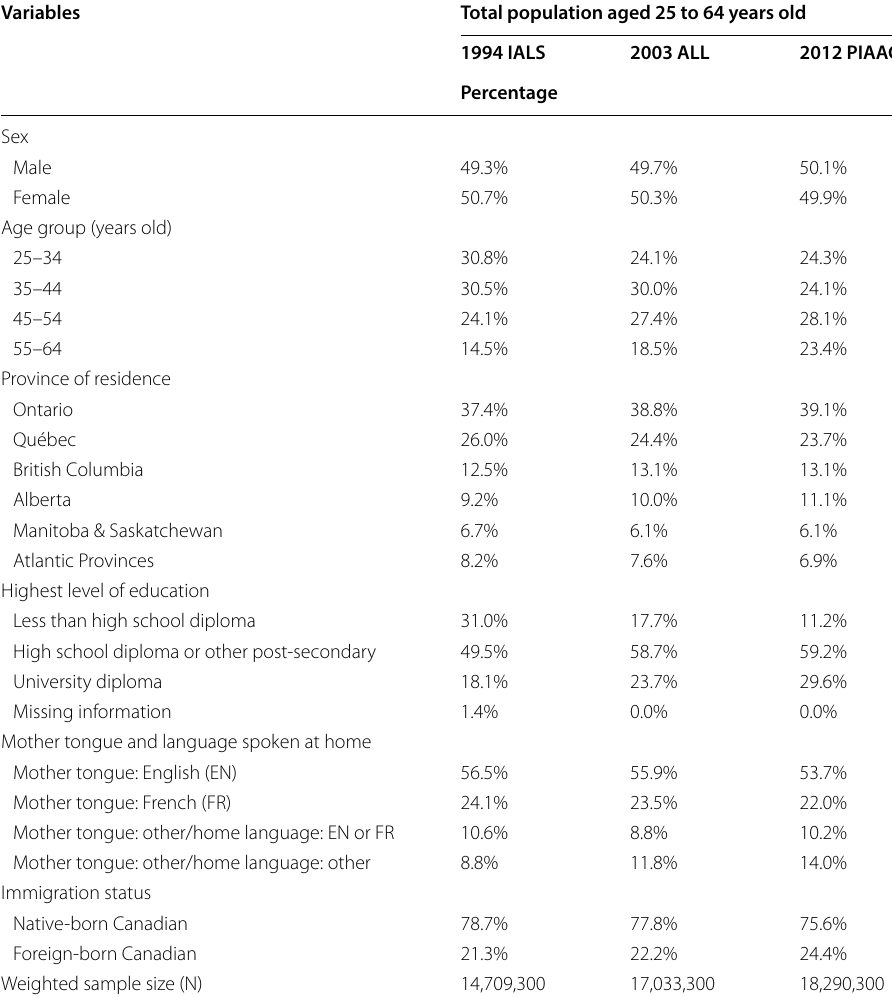
Table 2 Weighted distribution of the population aged 25 to 64 by selected variables,